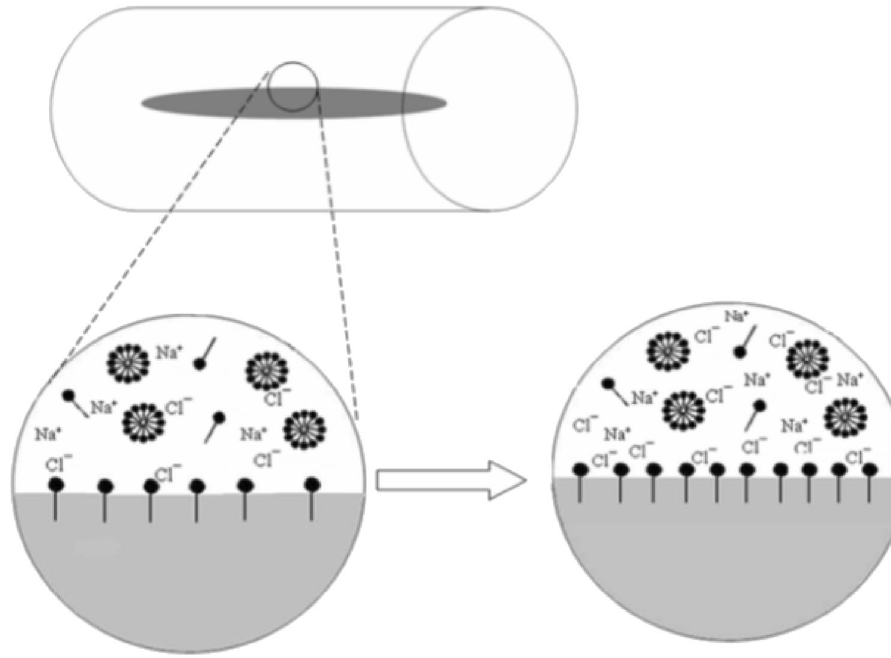
Fig. 11 Schematic of the syner- gic effect of ions and surfactants on IFT reduction at the oil/water interface (Zeinolabedini Hezave et al.